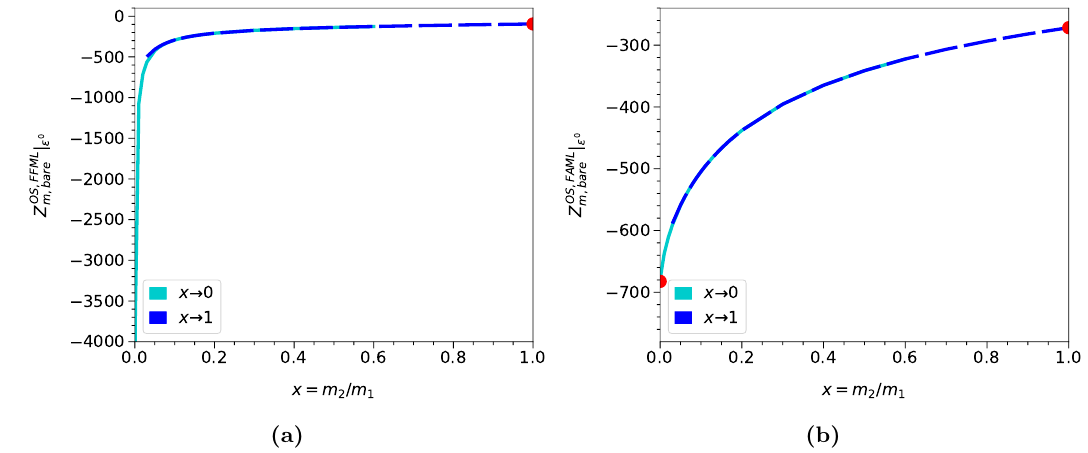
Figure 3 . Bare four-loop results for the colour structures C 2